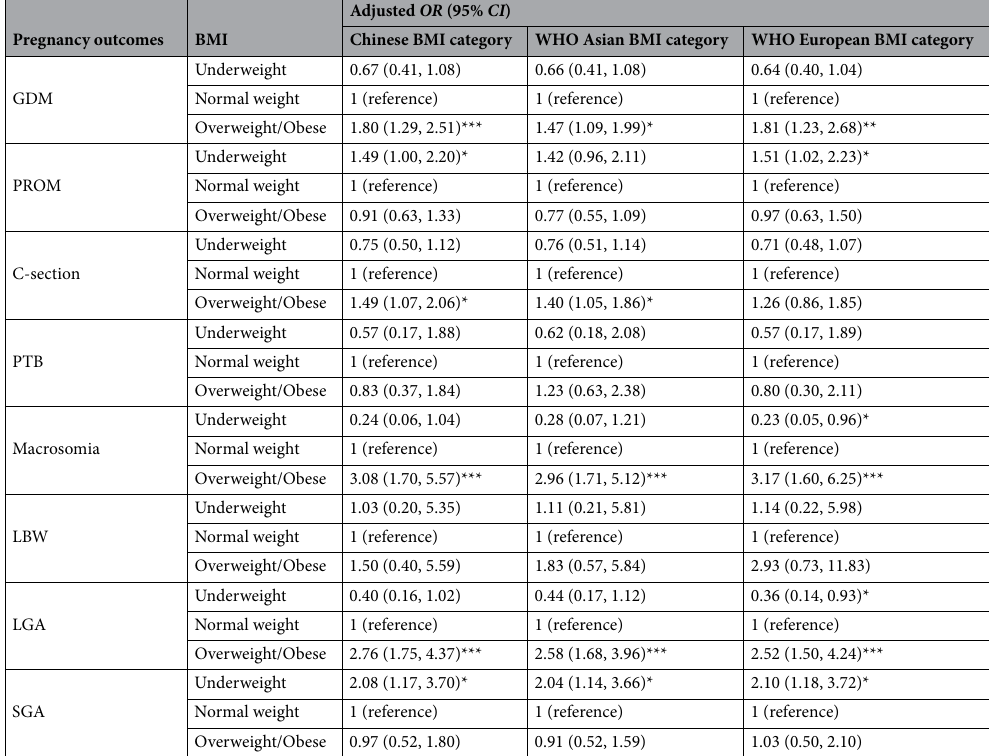
Table 2. Adjusted OR (95% CI ) for pregnancy outcomes by maternal BMI according to the Chinese, WHO Asian or WHO European classifications. Values are odds ratios (95% confidence intervals), * p < 0.05, ** p < 0.01, *** p < 0.001. Adjusted for maternal age, Han ethnicity, primiparity, history of miscarriage or abortion, maternal educational level, participant and partner’s income, maternal occupation status, gestational age at delivery, new born sex and gestational weight gain (continuous). GDM, PROM, C-section and PTB was not adjusted for gestational age at delivery and new born sex. BMI body mass index, OR Odds ratios, CI confidence intervals, GDM gestational diabetes mellitus, PROM premature rupture of membrane, C-section cesarean section, PTB preterm birth, LBW low birth weight, LGA large for gestational age, SGA small for gestational age.